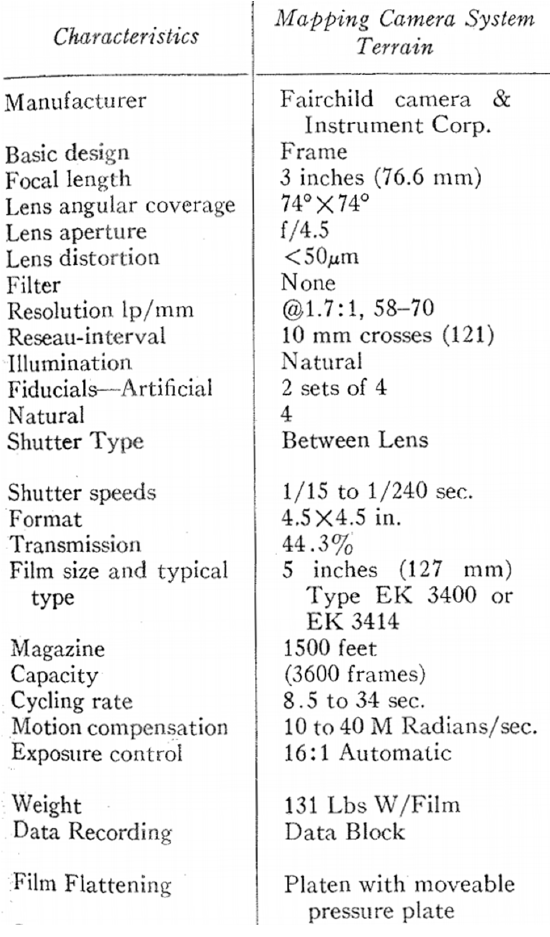
Table 1: Apollo Metric Camera characteristics (from Light, 1972).